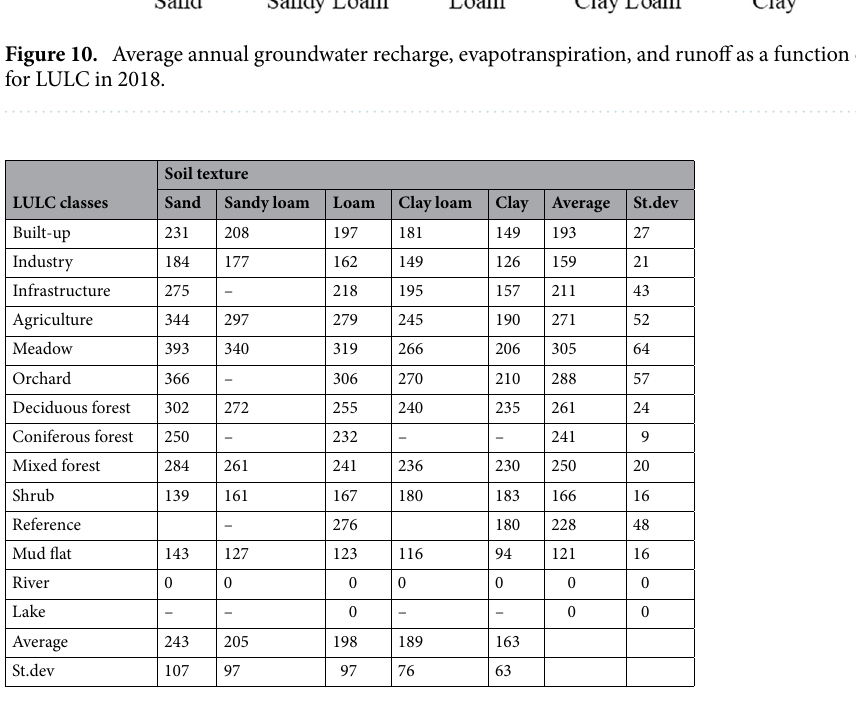
Table 4. Average annual groundwater recharge across different combinations of soil texture and LULC in 2018. –, (no value) as there is no such LULC for a given soil